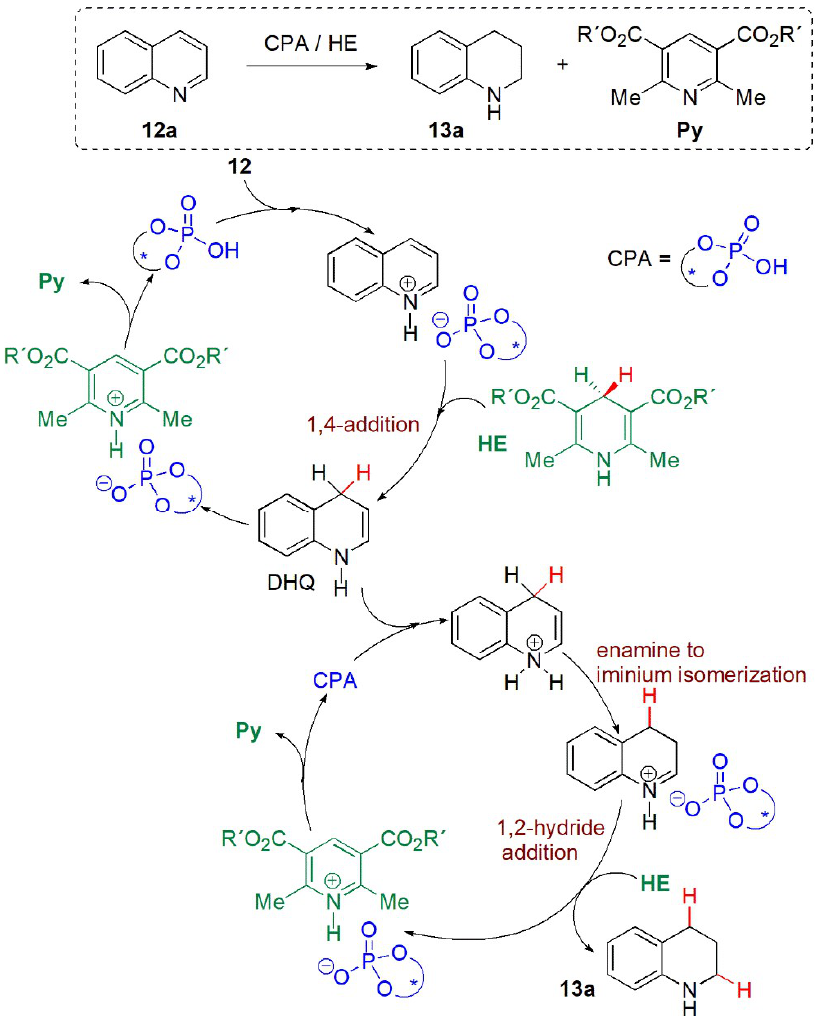
Figure 8. The mechanism initially proposed for the ETH of quinolines [49].